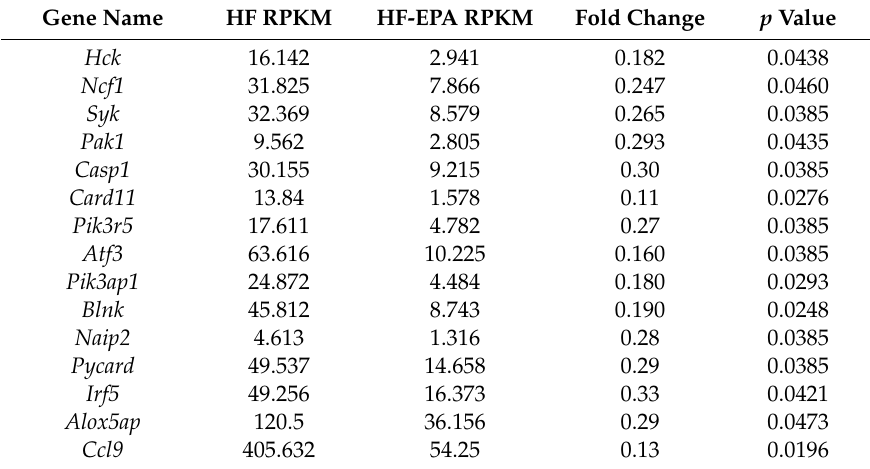
Table 3. Di ff erentially expressed genes data of intracellular molecules downregulated by EPA in